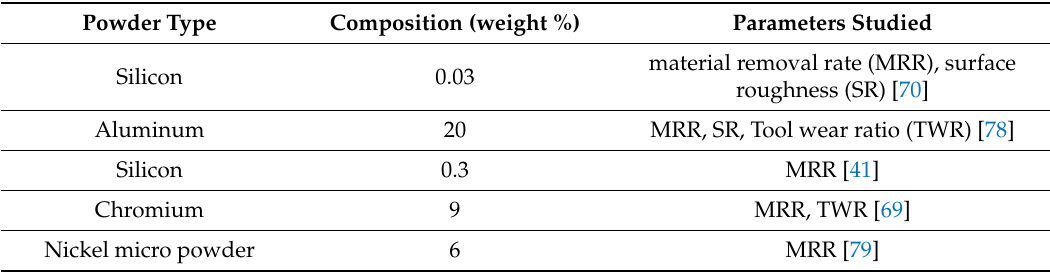
Table 1. Details of general composition of various powders used by researchers for di ff erent EDM processes.